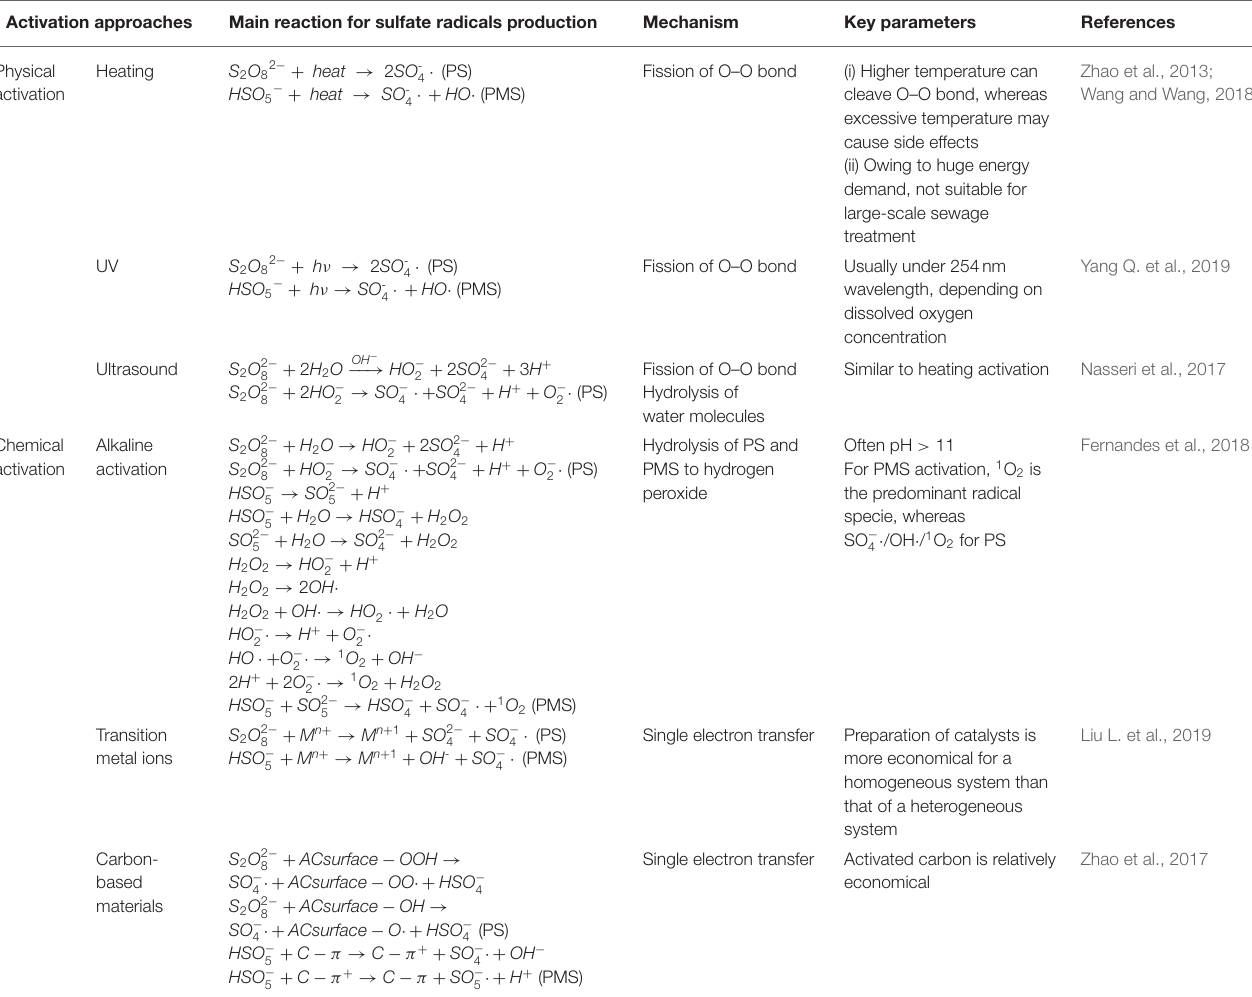
TABLE 1 | Summary of the different persulfate (PS) and peroxymonosulfate (PMS) activation approaches: pathways, mechanism, and key